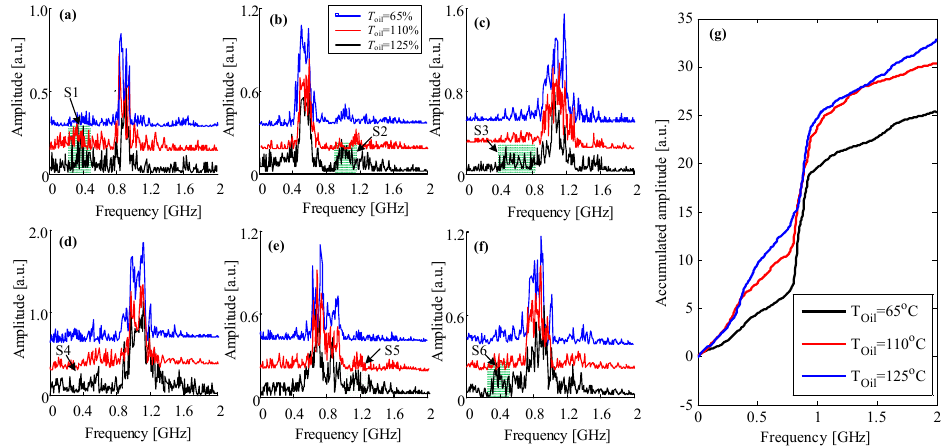
Figure 11. FFT spectra of different PD models, the subfigure ( a – f ) refers to model a to model f, ( g ) refers to the accumulated amplitude of FFT spectrum of model a under different oil temperature.